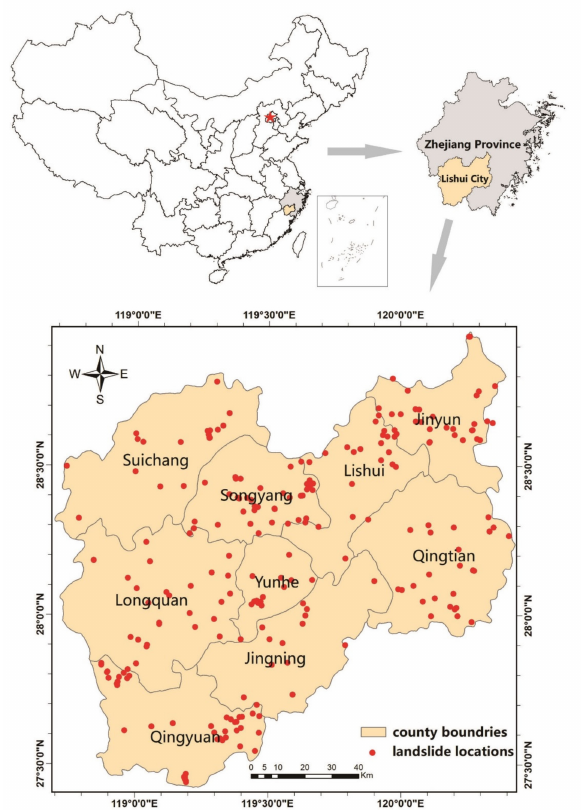
Figure 1. Location map of the study